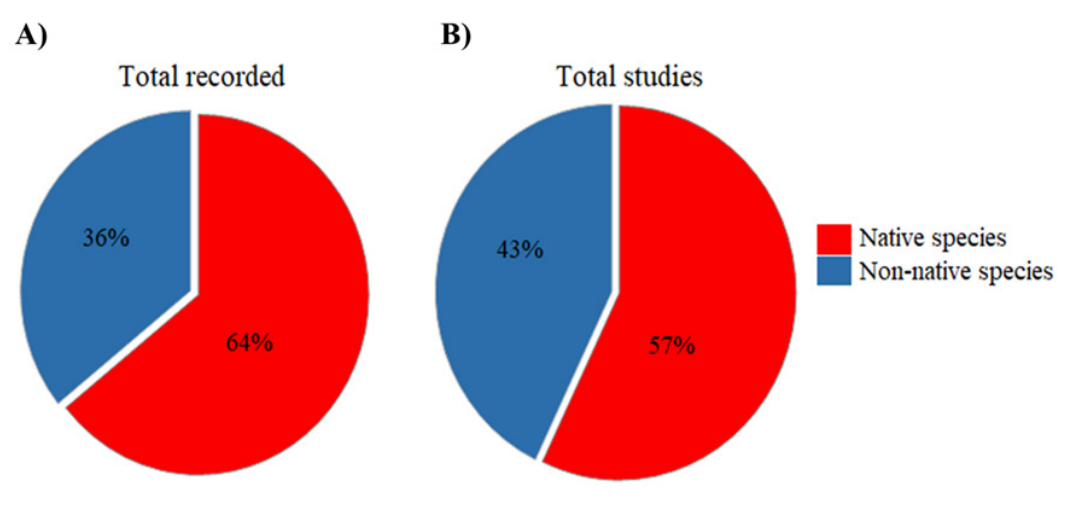
Figure 7. (A) Percentage of native and non-native fish registered in the upper Parana River floodplain according to Ota et al. (2018); (B) Percentage of native and non-native hosts in the floodplain (Ota et al., 2018) studied by the Ichthyoparasitology Laboratory.